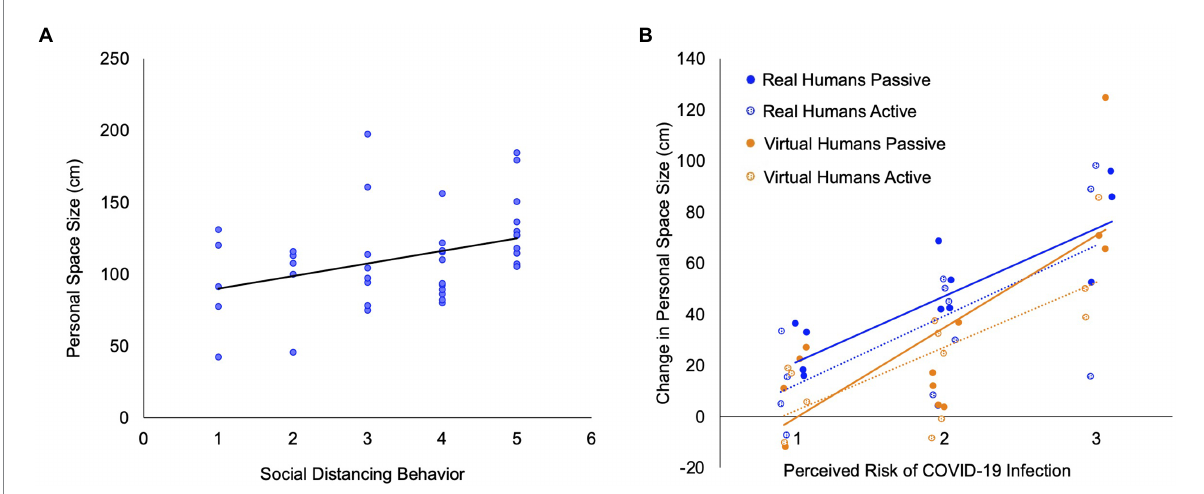
FIGURE 3 Associations with social distancing behavior and perceived risk of being infected with COVID-19 during the pandemic. (A) There was a significant correlation between personal space size during the pandemic and social distancing behavior (as assessed using ratings of the statement “I stay at least 6 feet away from people when I am outside”; r (41) = 0.358, p = 0.019) in the subjects assessed during the pandemic (31 subjects of Cohort 1 and 12 subjects of Cohort 2; total n = 43). Two subjects of Cohort 1 did not complete the scale measuring beliefs and experiences related to the pandemic. (B) Across all four personal space measurements (i.e., real and virtual, passive and active SDP trials), the change in personal space size observed in Cohort 2 that occurred following the onset of the pandemic (During – Before) was significantly positively correlated with perceived risk of COVID-19 infection (Real: passive: r (10) = 0.745, p = 0.005, active: r (10) = 0.656, p = 0.021; Virtual: passive: r (10) = 0.603, p = 0.038, active: r (10) = 0.738, p =